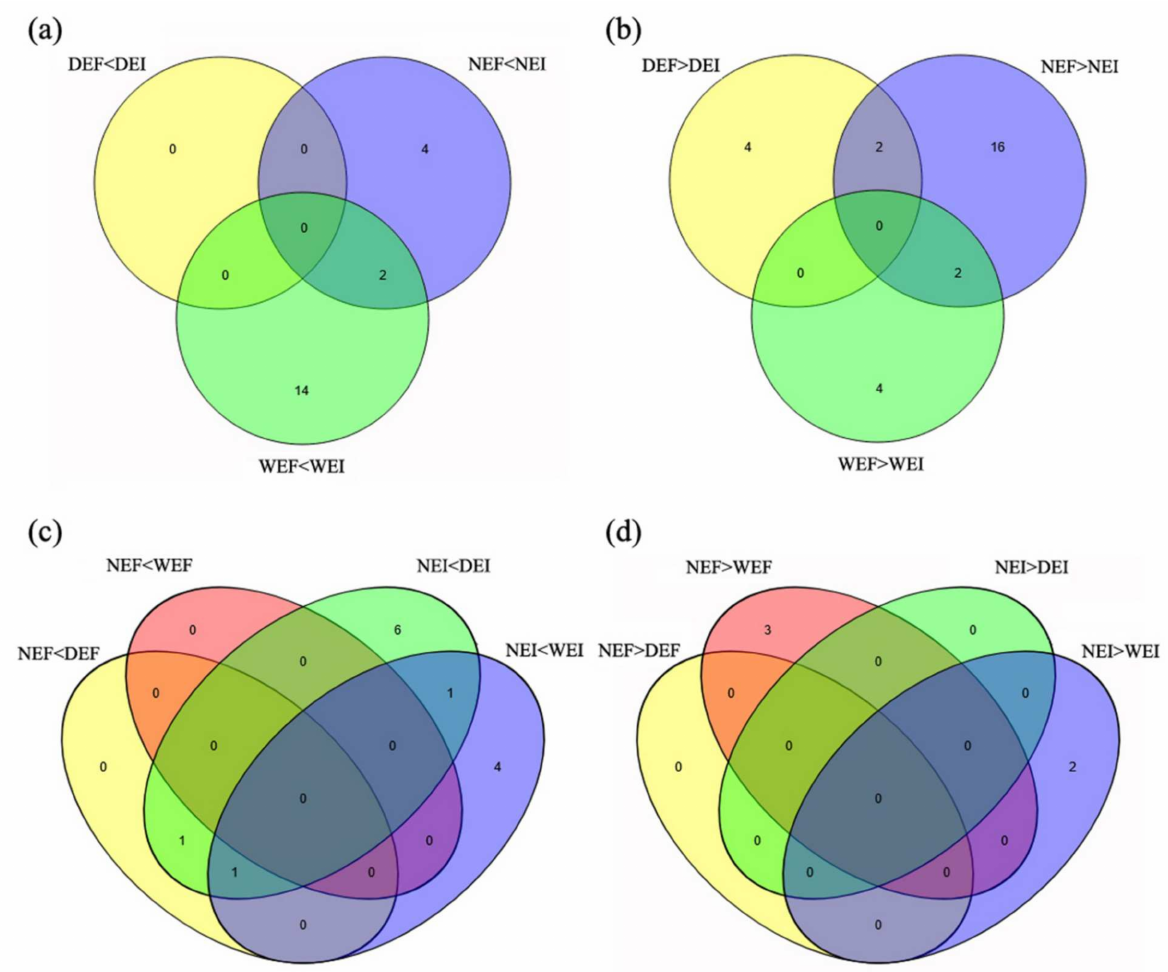
Figure 1. Numbers of upregulated and downregulated DEGs associated with the plant hormones under the status of Epichloë gansuensis ( a , b ) and different moisture content ( c , d ) in Achnatherum inebrians plants (D: drought, N: normal, W: well-watered, EI: endophyte infected and EF: endophyte